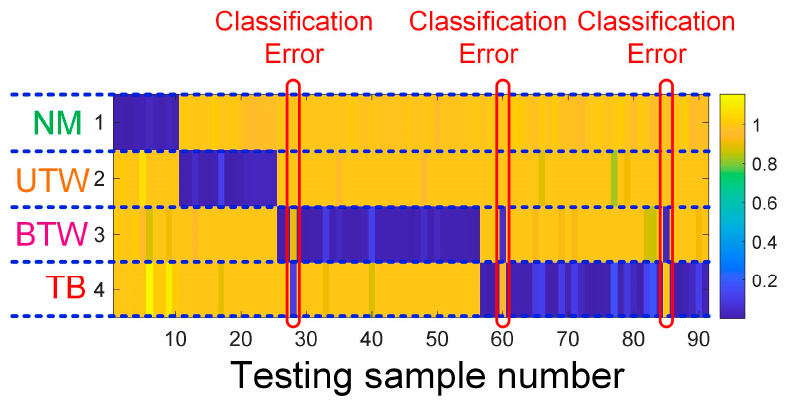
Figure 27. RPD: reconstruction error matrix.